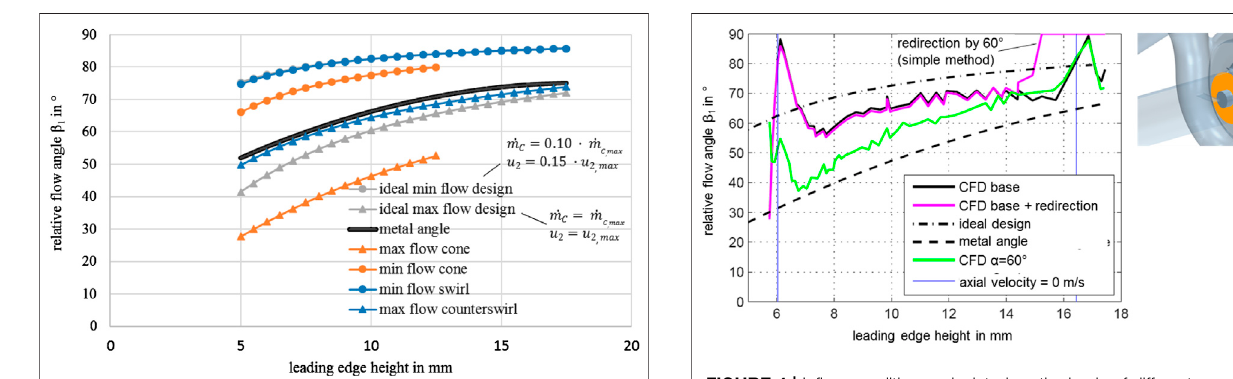
FIGURE 4 | In fl ow conditions calculated on the basis of different methods for a medium fl ow rate and a medium peripheral